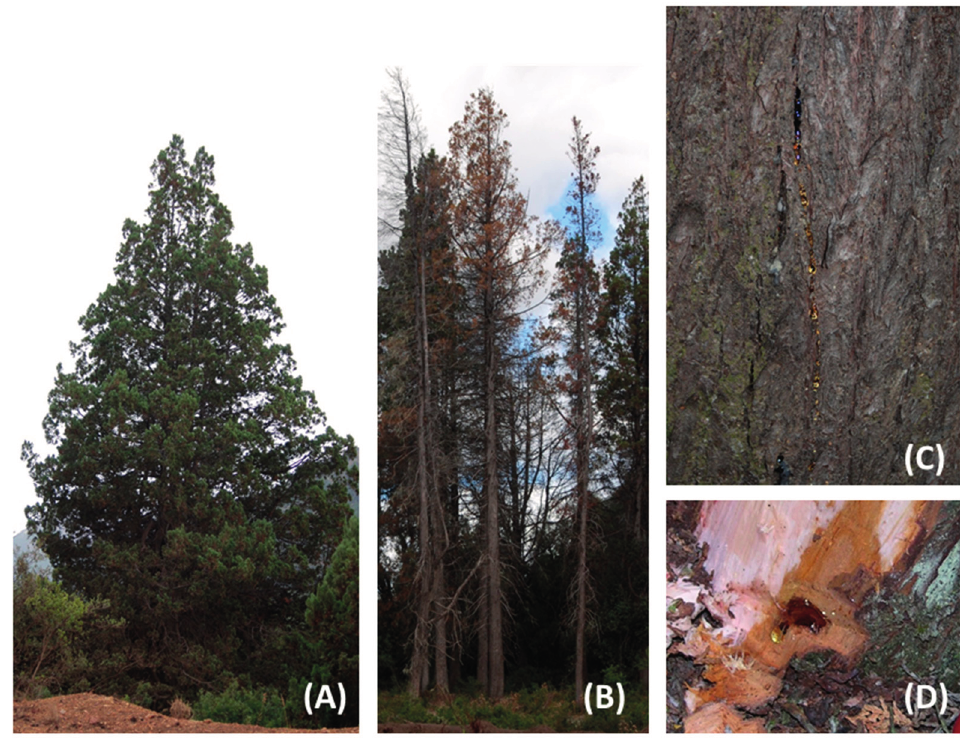
Figure 6. ( A ) Healthy Austrocedrus chilensis tree showing no symptoms of Phytophthora austrocedri infection; ( B ) Diseased Austrocedrus chilensis tree infected with Phytophthora austrocedri ; ( C ) Resin exudates on bark of the tree base; ( D ) Detail